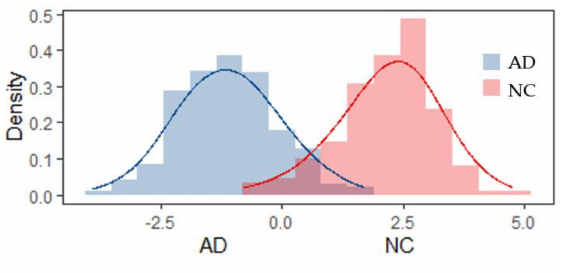
Figure 5. Distribution of linear combination of the features of AD or NC after